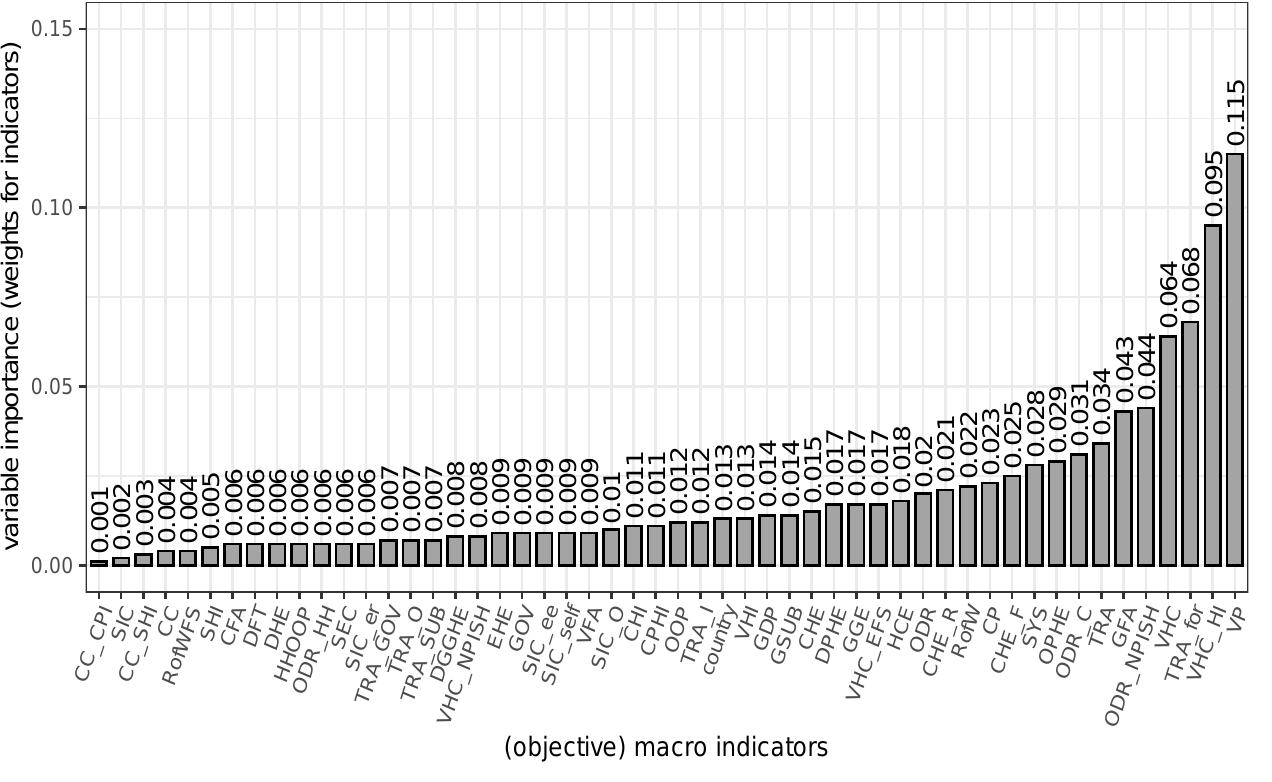
Figure 3. Variable importance of each macro indicator from the GHED subset. Causal forest with dependent variable confidence in the health care system and independent variable self-rated health. Meaning of macro indicator shortcuts see Table 1, N =